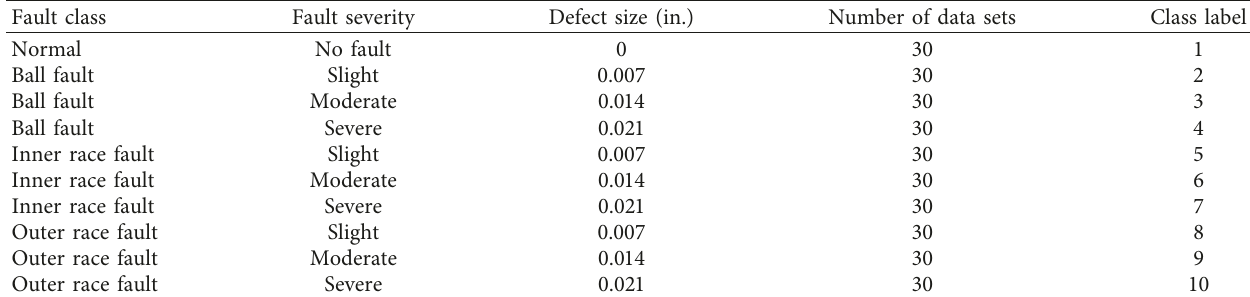
Table 4: Descriptions of the experimental data sets.